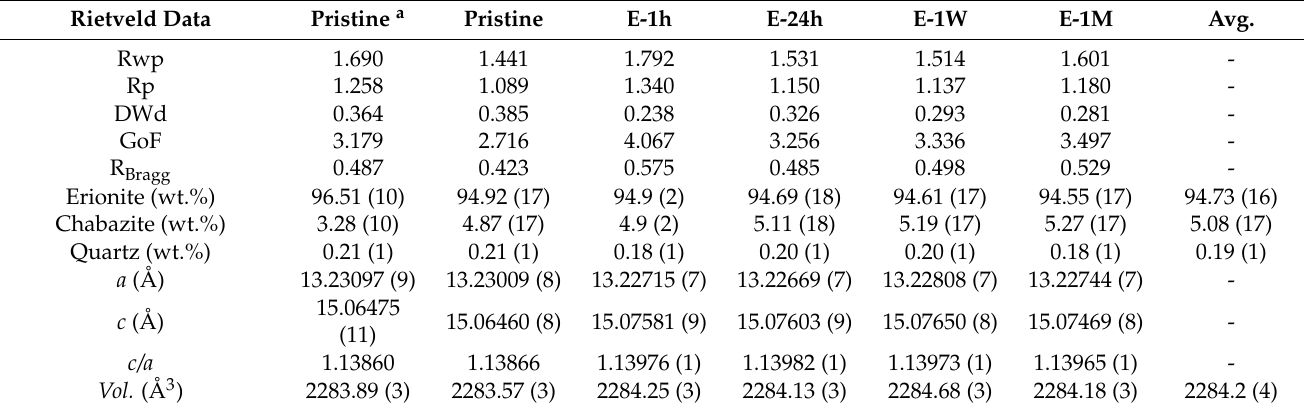
Table 1. Miscellaneous data of the mixed Pawley–Rietveld refinements. a Reference data of Pacella et al. [35]. - refers to data not calculated.